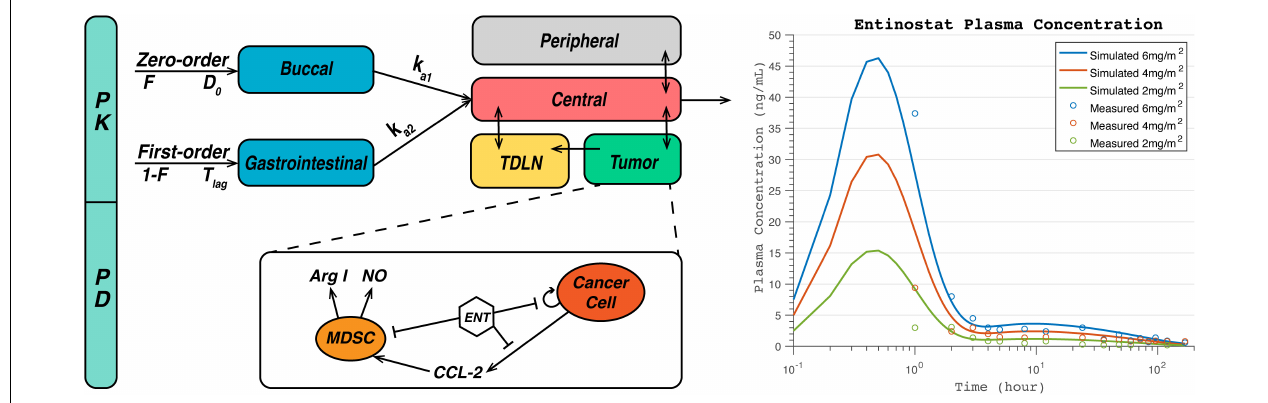
FIGURE 2 | Diagram of pharmacokinetic/pharmacodynamic (PK/PD) module for entinostat (A) and simulated and measured plasma concentration at doses of 2, 4, 6 mg/m 2 (B) . A fraction of dose, F, is immediately absorbed by the patients via zero-order buccal absorption over a time duration D 0 into the buccal compartment, and the rest of the dose, 1-F, is absorbed after a time period T lag via first-order gastrointestinal (GI) absorption into the gastrointestinal compartment. The drug in buccal and gastrointestinal compartments are then absorbed into the central compartment via first-order absorption, and transported into the peripheral and the tumor compartments via passive diffusion. For pharmacodynamics of entinostat, it inhibits nitric oxide (NO) and arginase I (Arg-I) production by myeloid-derived suppressor cells (MDSCs), CCL2 production by cancer cells, Arg-I activity, and cancer cell